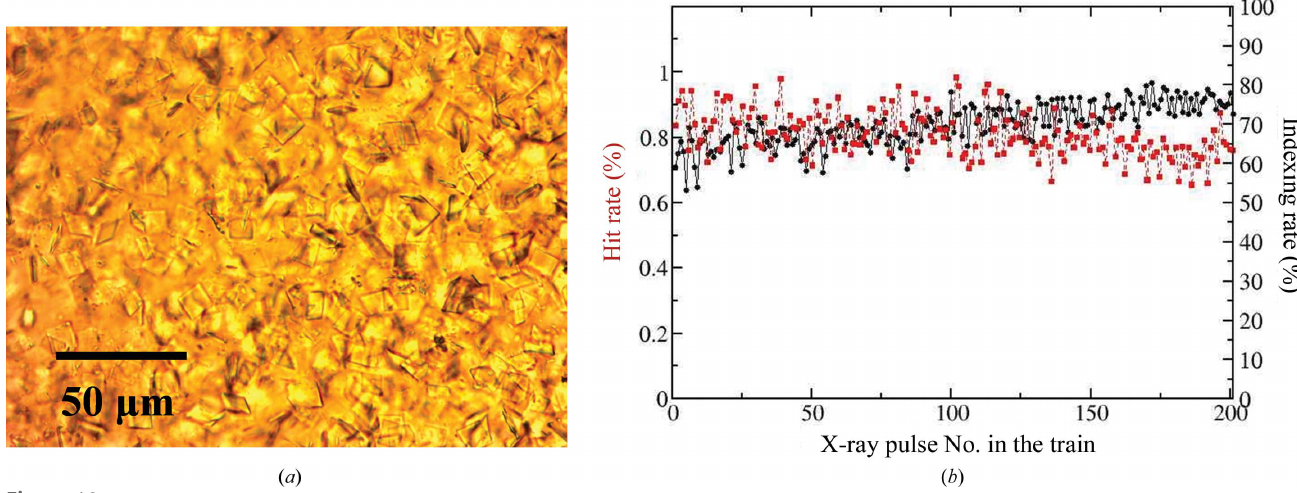
Figure 10 Crystals, hit and indexing rates. ( a ) Microscopic image of the platelet crystal form of BlaC and ( b ) exemplary hit (red squares) and indexing (black spheres) rates from BlaC/CEF mixing as a function of the pulse ID in the train. Both rates are stable across the entire pulse